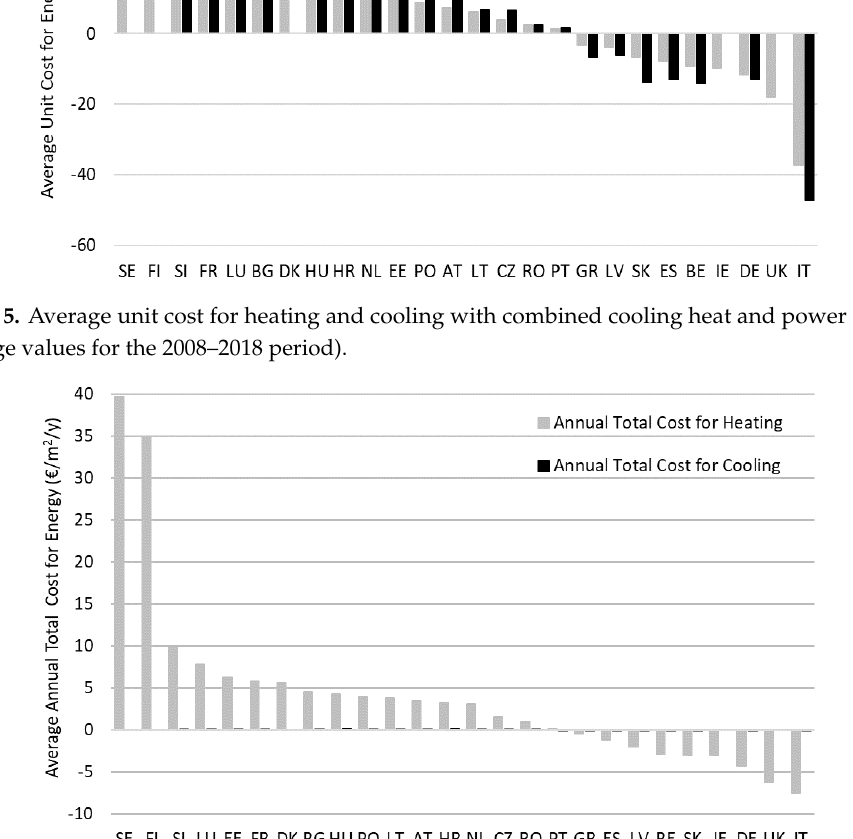
Figure 6. Average annual total cost for heating and cooling per unit area with CCHP (average annual values during the 2008–2018 period).